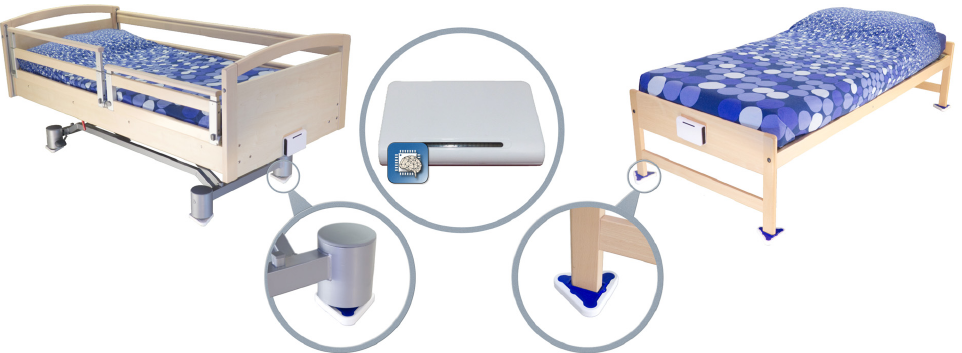
Figure 1. Human in bed monitoring through signals generated by sensors placed under the bed. Under each of the four bed legs, two sensors are placed: one weight sensor and one motion sensor. Thus, eight sensor measurement values are generated continuously over time for further processing by the anomaly detection intelligent system [25].